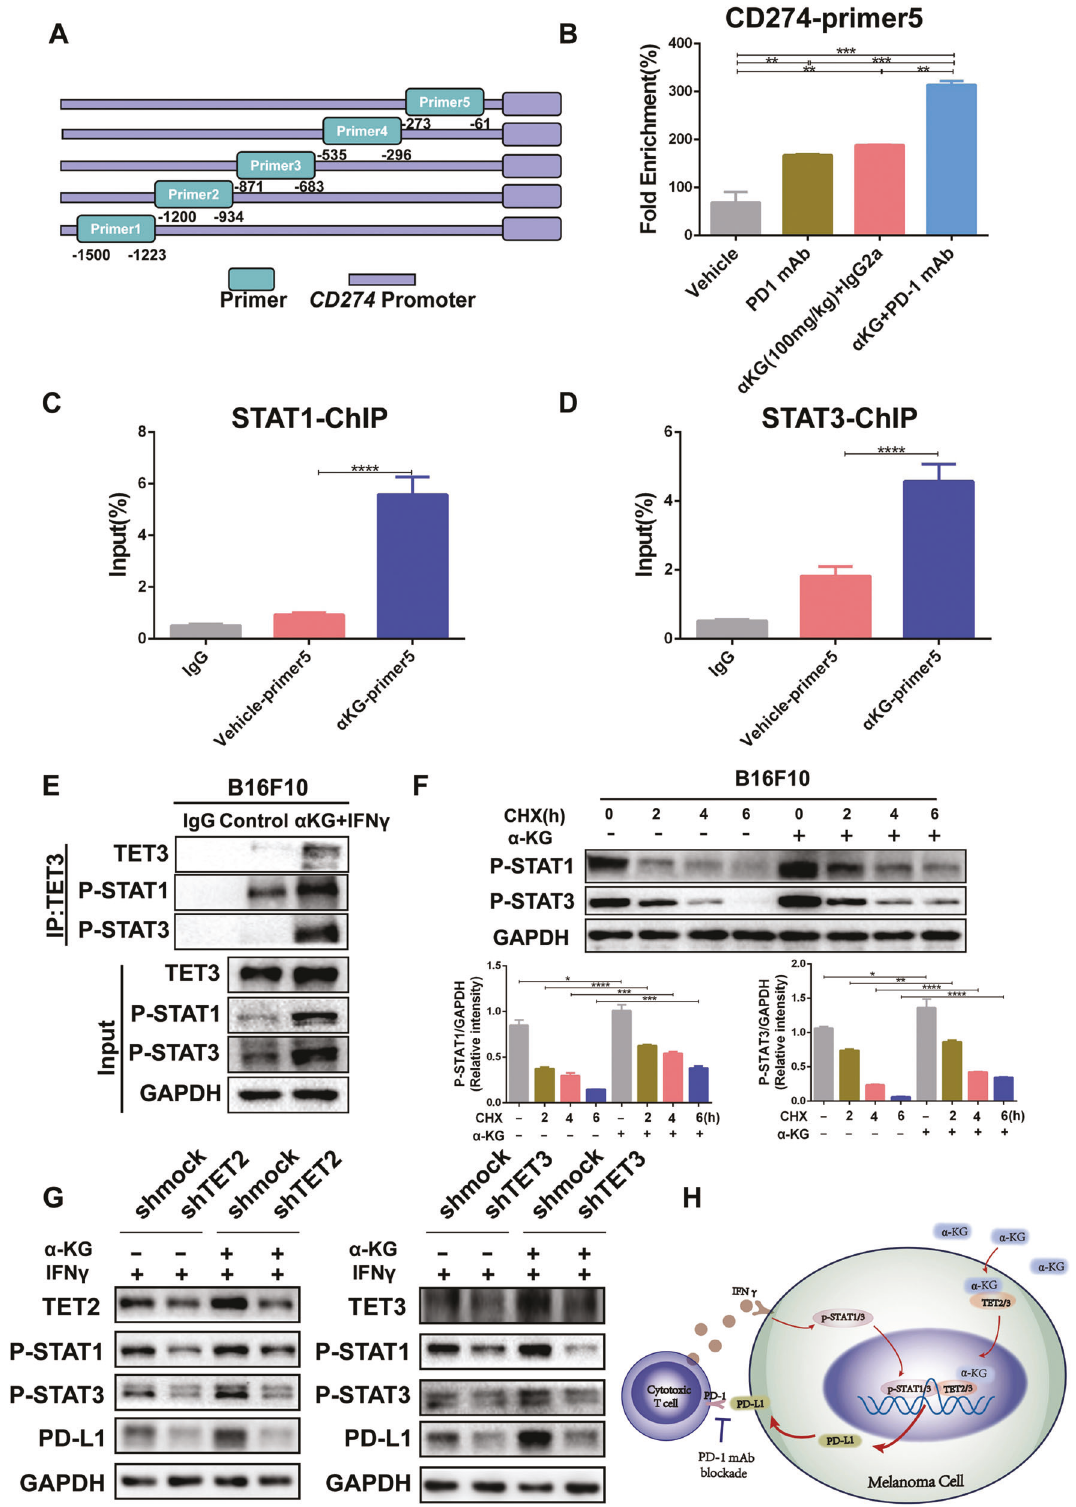
Fig. 6 Regulation of PD-L1 by the α -KG-TET2/3-p-STAT1/3 axis is required. A Designed primers for hMeDIP analysis and ChIP experiments. B 5-hmC levels of PD-L1 promoters in B16F10 tumor-bearing mouse tissues after the designated treatments. C , D ChIP-qPCR was performed to detect the binding of STAT1 C or STAT3 D to PD-L1 promoter sites in B16F10 cells with or without α -KG treatment. E Immunoprecipitation analysis of TET3 with p-STAT1/3 in B16F10 cells receiving the designated treatments. F P-STAT1/3 protein levels at different time points after IFN γ stimulation in B16F10 cells treated with CHX (100 mg/mL) or α -KG (200 μ m). G The expression of p-STAT1/3 and PD-L1 protein levels was detected by immunoblotting after knocking down TET2 (left panel) /TET3 (right panel) under the designated treatment. H Schematic diagram of the mechanism. Multiple experimental data ( n = 3) are counted and presented according to the statistical methods, and an asterisk (*) indicates the degree of signi fi cant difference. Cell Death and Disease (2023)